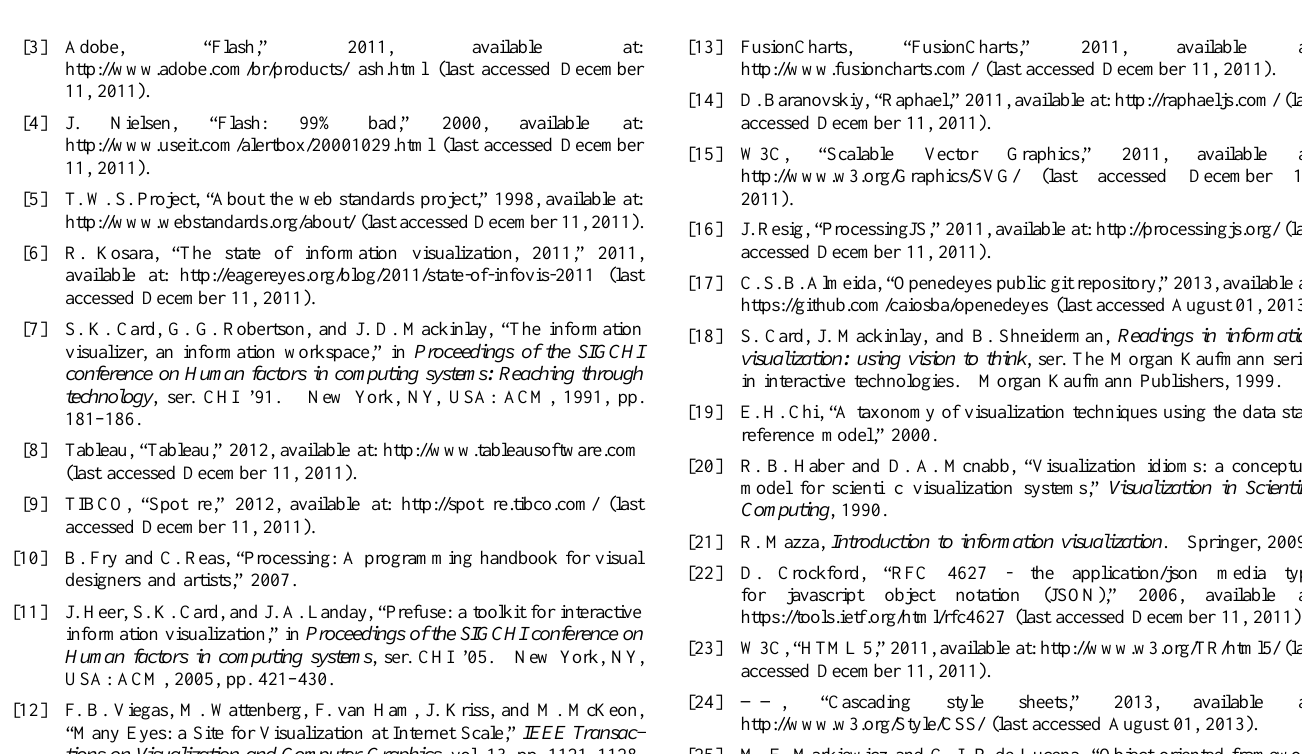
Fig. 14. Common datafile represented as a Choropleth map: just one non-numeric variable (the country itself) and one numeric variable (total reports) are represented in this chart